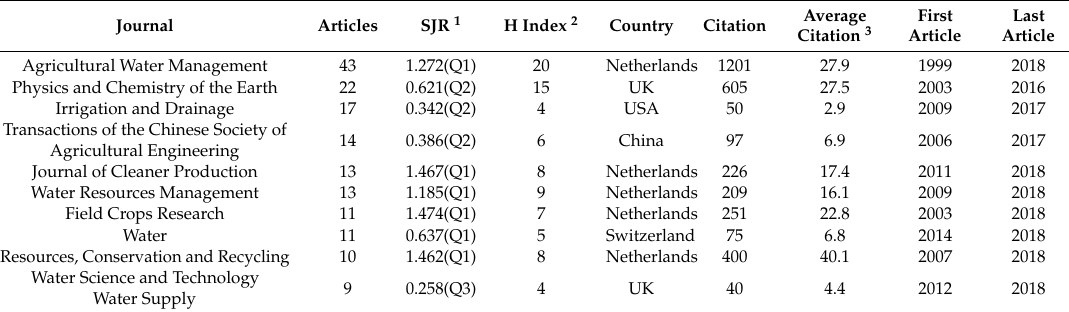
Table 2. Main characteristics of the most active journals in RWHI research.